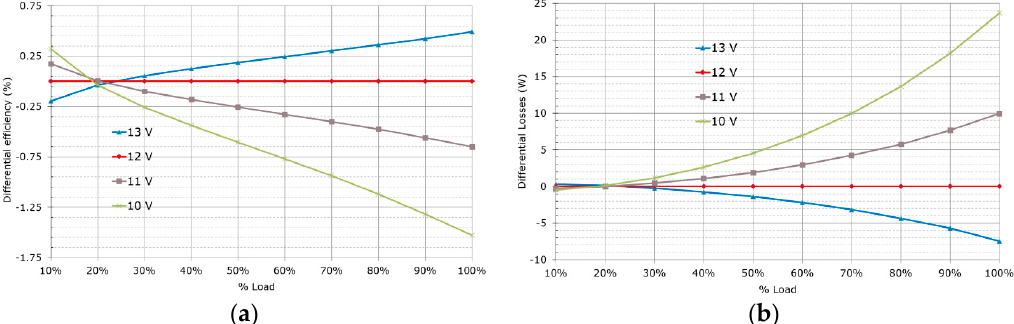
Figure 19. Performance comparison for different nominal output voltages: ( a ) differential efficiency; ( b ) differential losses.